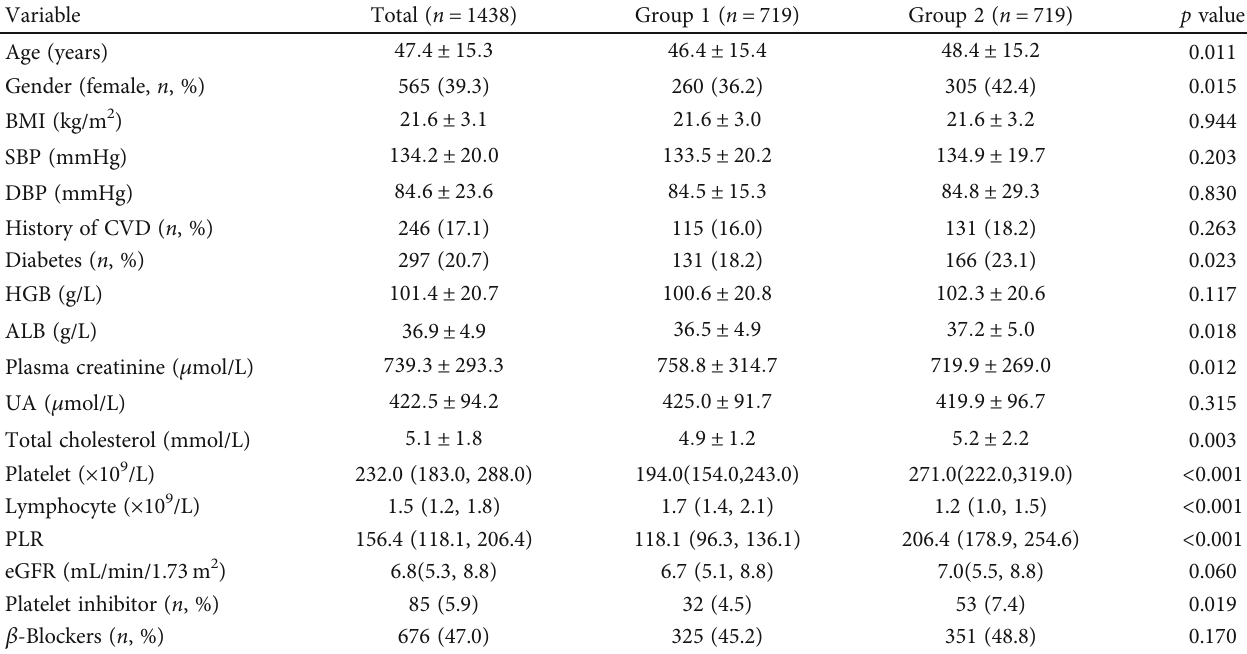
Table 1: Baseline characteristics of the study